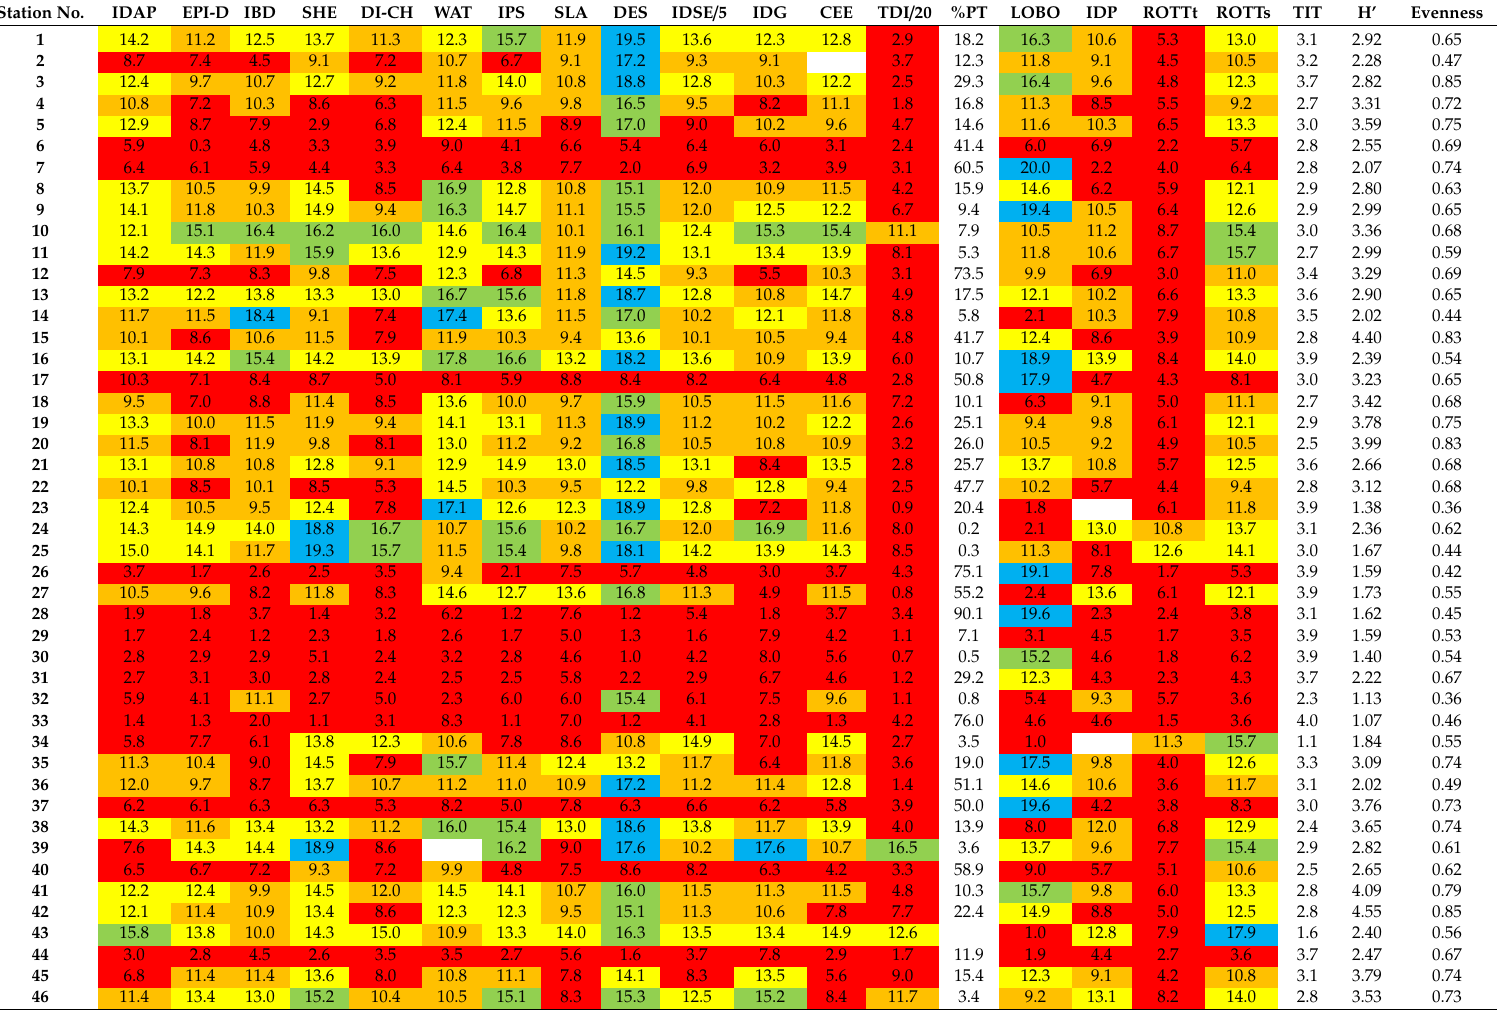
Table 5. The diatom index values at sampling stations and corresponding ecological status (blue—high, green—good, yellow—moderate, orange—poor, red—bad). Station